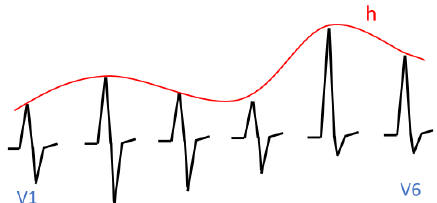
Figure 10. Abnormal R-wave